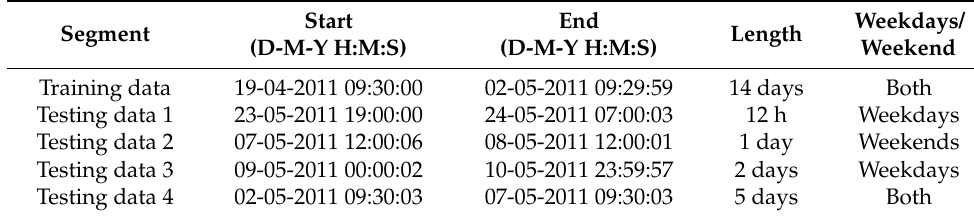
Table 1. Training and testing data.